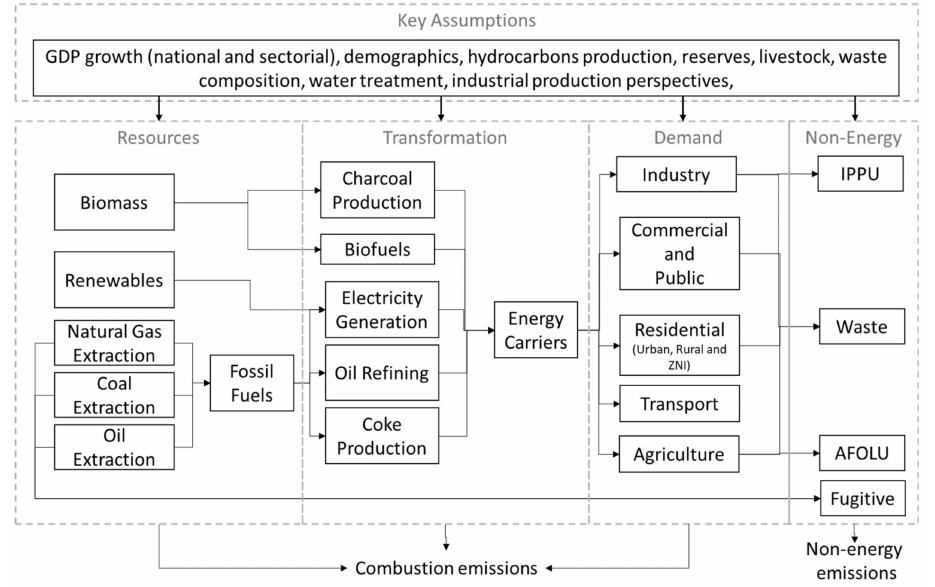
Figure 2. Colombia LEAP model